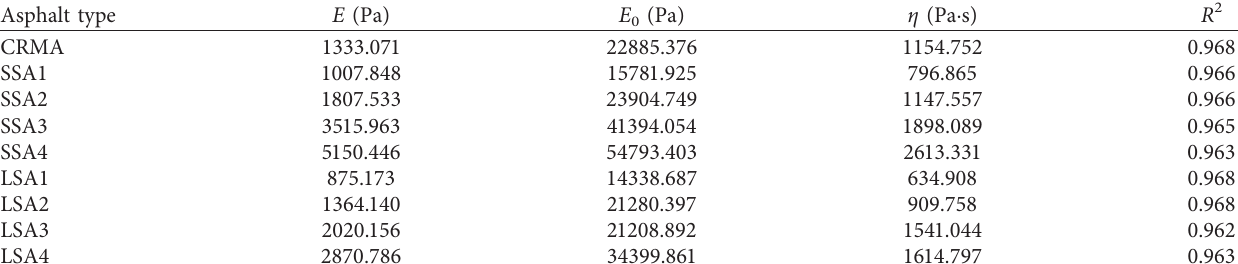
Table 3: Storage modulus fitting parameter results.